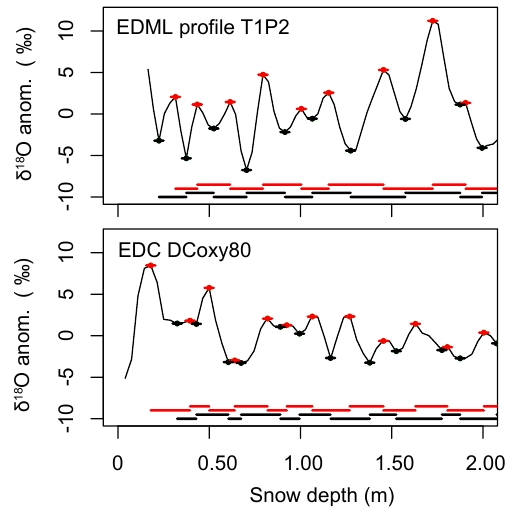
Figure 1. Example isotope profiles from EDML and EDC. Both profiles are visually similar despite the differing time periods cov- ered, ∼ 10yr for EDML and ∼ 25yr for EDC, and annual snow layer thicknesses, ∼ 21cm for EDML and ∼ 8cm for EDC. Also shown is an example of the automatic estimation of isotopic cycle length. Red and black dots show the identified maxima and minima. The short horizontal lines overlaying these dots indicate the ± 6cm region a maximum (minimum) must be above (below) to be identi- fied as an extremum. The longer black and red horizontal lines at the bottom of the figure indicate the identified distances between sub- sequent maxima or minima. For more examples of isotope profiles see Casado et al.